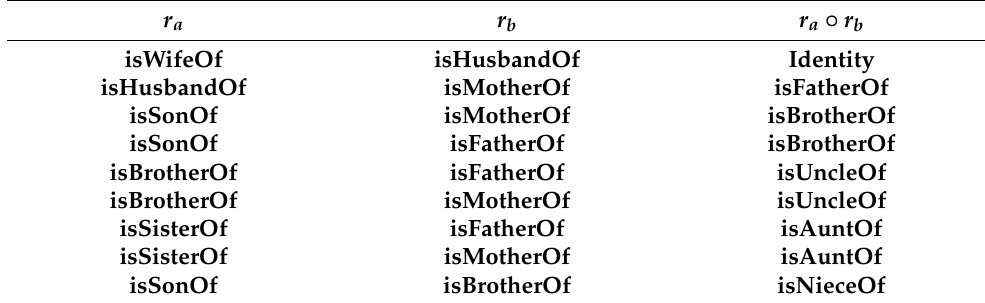
Table 3. Common sense knowledge in KINSHIP.